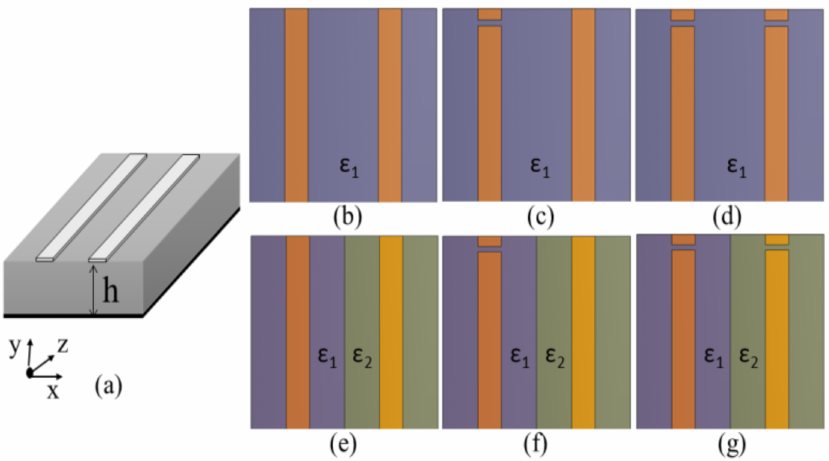
Figure 3. ( a ) The models for analyzing the coupling between two microstrips depending on the dielectric material and line type, for a uniform dielectric material ( b ) double straight line (uniform- DSL), ( c ) one straight line and one gap line (uniform-OSLOGL), ( d ) double gapped lines (uniform- DGL), ( e ) (interleaved-DSL), ( f ) (interleaved-OSLOGL) and ( g )